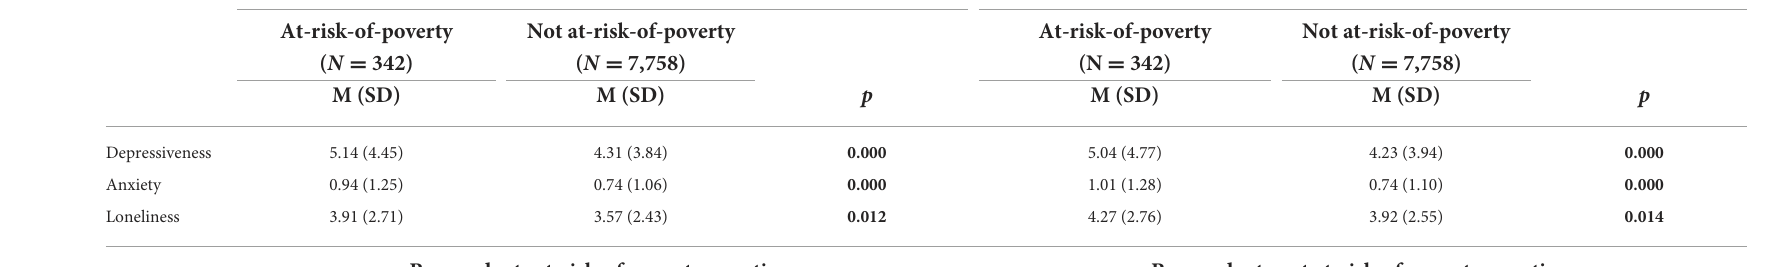
TABLE 4 Depressiveness, anxiety, and loneliness of men and women living and not living at-risk-of-poverty ( N =